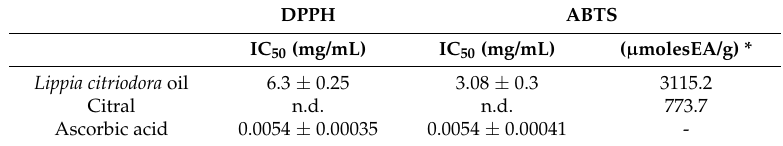
Table 4. Antioxidant activity of the essential oil of Lippia citriodora and citral using the DPPH and ABTS